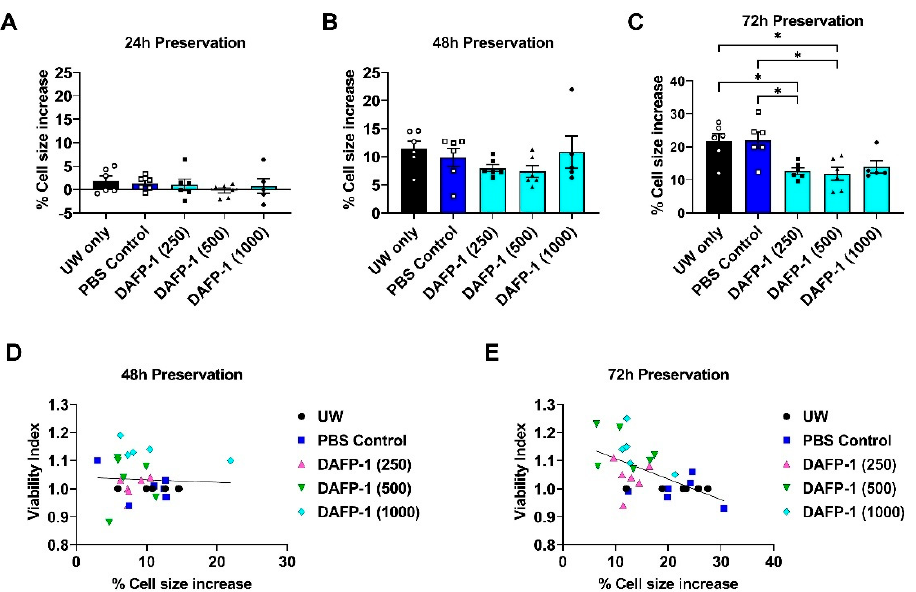
Figure 2. Changes in the size of INS-1 cells cold preserved in the UW solution supplemented with DAFP-1. The INS-1 cells were cold preserved in UW alone, UW solution containing vehicle (PBS control) or with 250, 500, and 1000 µ g/mL DAFP-1 for up to 72 h, and the live cell sizes were analyzed along with the cell viability using the trypan blue staining. The percent increases of the live cell size before- and post-cold preservation was calculated as the difference of the mean diameter of the live cells between the post-preservation and pre-preservation divided by that of the pre-preservation at ( A ) 24 h, ( B ) 48 h, and ( C ) 72 h after cold preservation (open circle for UW only, open square for PBS control, solid square, solid triangle and solid circle for DAFP-1 250, 500 and 1000 µ g/mL, respectively). The data show the mean ± standard error of five to six independent experiments, * p < 0.05 by the one-way ANOVA. ( D ) The overall correlation between the percentage of cell size increase and the viability index of the corresponding samples from all the groups at 48 h preservation and ( E ) 72 h preservation (r = − 0.57, r 2 = 0.33, p < 0.005, N = 5 independent experiments with 29 data points).